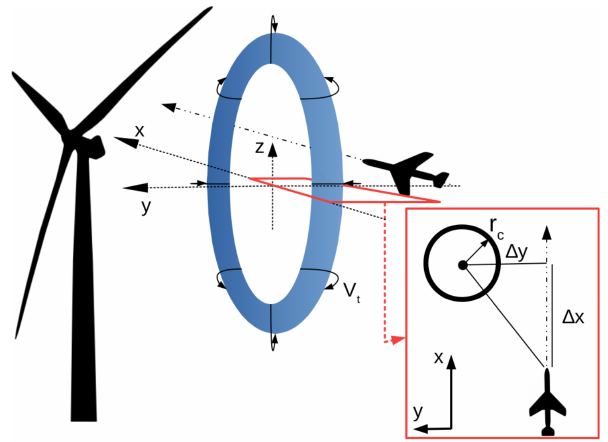
Figure 7. Simplified sketch of a vortex pair passed by the UAS to the right. In reality, it would have rather a helical pattern than a ring shape. Velocities and axis are according to meteorological standards; therefore, axis and orientation are according to the in situ conditions. The y axis points north; x axis points east. At hub height, the w component (along z axis) vanishes. The red rectangle illustrates a top view of a tip vortex with distance (cid:49)y to the